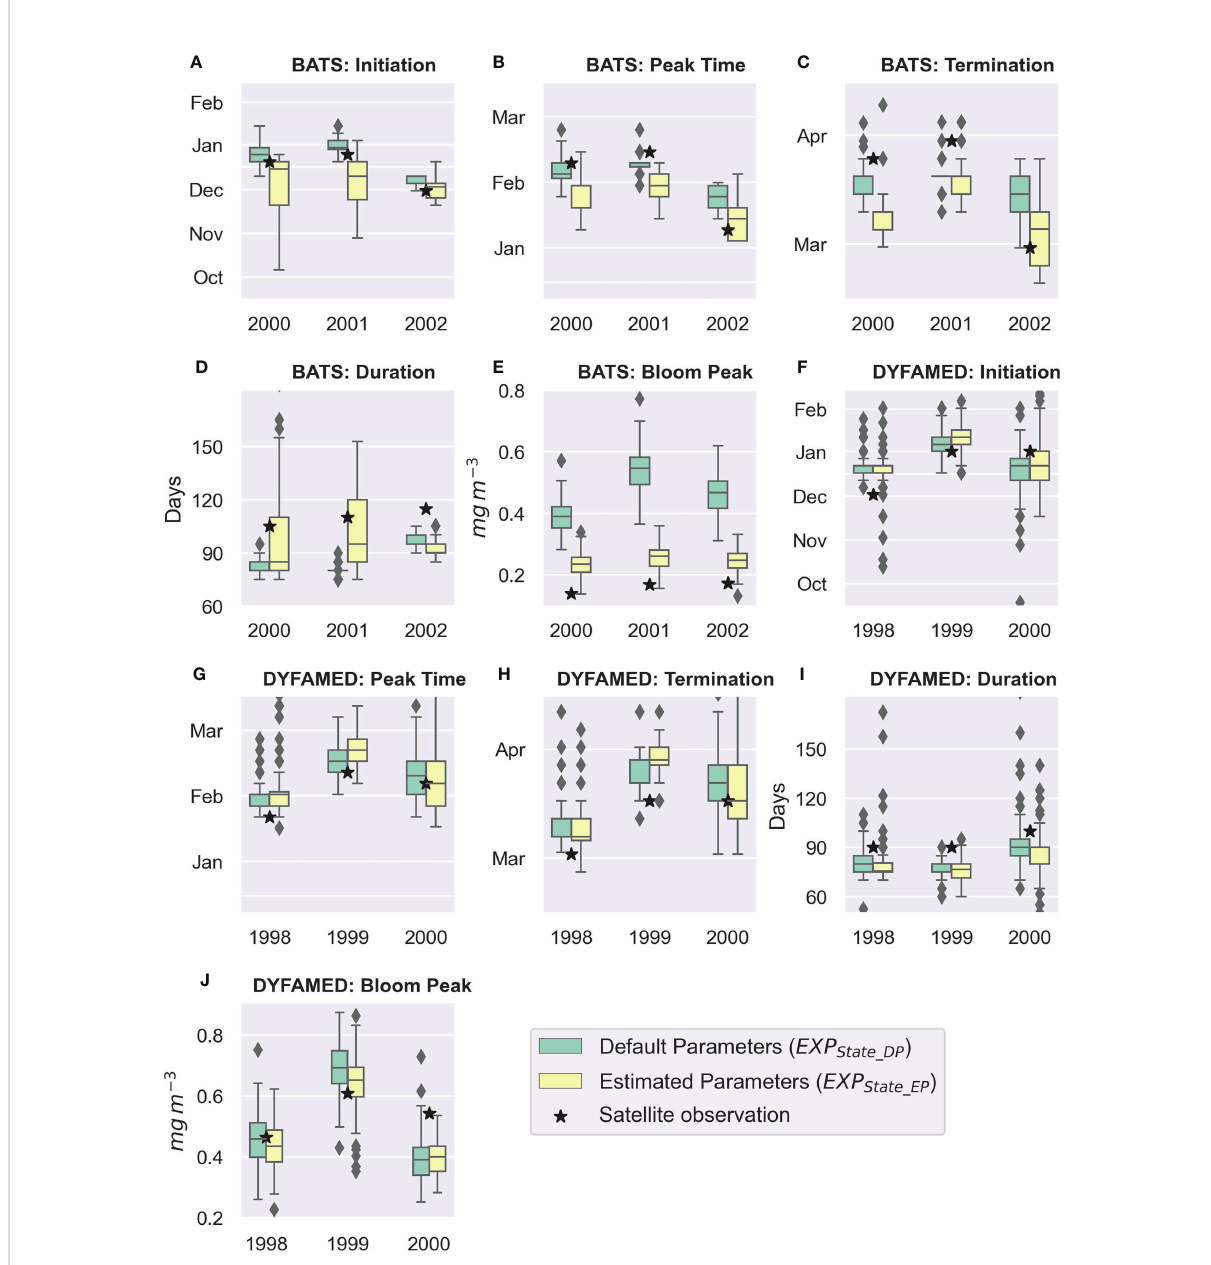
FIGURE 10 Phytoplankton phenology metrics (A – E) bloom initiation, peak time, termination, duration, and peak value at BATS and (F – J) DYFAMED. The black stars are calculated from satellite data; the boxes show the quartiles of the ensemble of the combined chl-a and NPP assimilation, whereas the whiskers extend to show the rest of the ensemble members except for points determined to be “ outliers ” using the inter-quartile